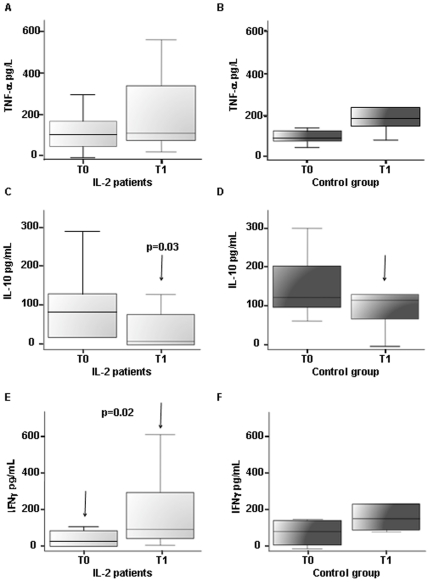
Production of TNF-α (A,B), IL-10 (C,D) and IFN-γ (E,F) in PBMC cultures before (T0) and after (T1) IL-2 adjuvant treatment (A,C,E) compared to cART treatment alone in control group (B,D,F).Following IL-2 treatment significant increases in PBMC's IFN-γ production (P = 0.02), and substantial reduction in IL-10 levels were observed resulting in significant difference between IL-2 patients and controls at T1 (P = 0.03). Significant result in IL-2 treated patients are emphasized by black arrows indicating the compared groups with respective P value.